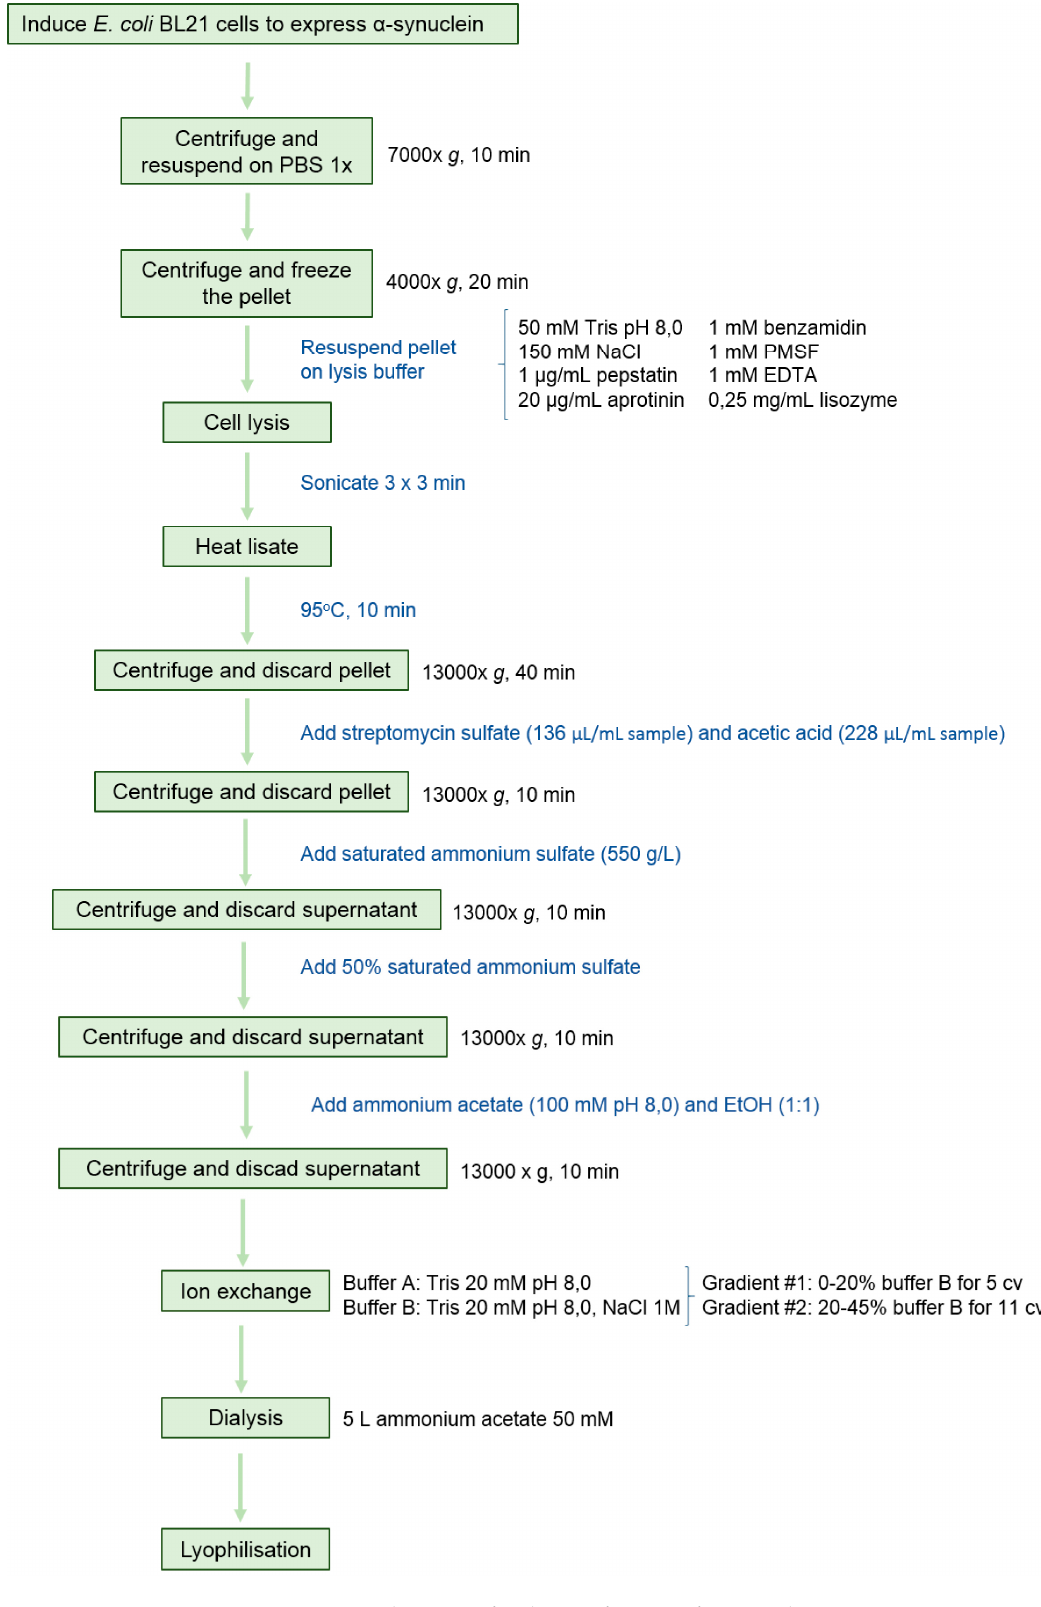
Figure 1. General strategy for the purification of α -synuclein.